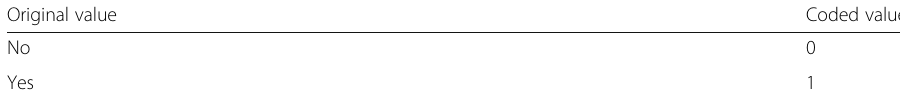
Table 4 Dependent random variable Y